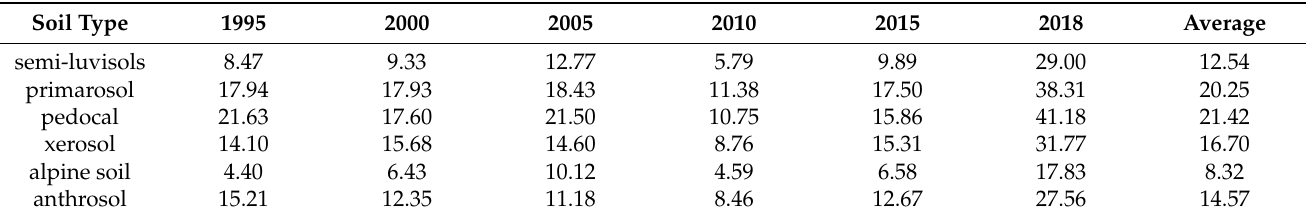
Table 6. Modulus of soil erosion in different years at different soil type in the South and North Mountains of Lanzhou City (unit: t/(km 2 · a)).